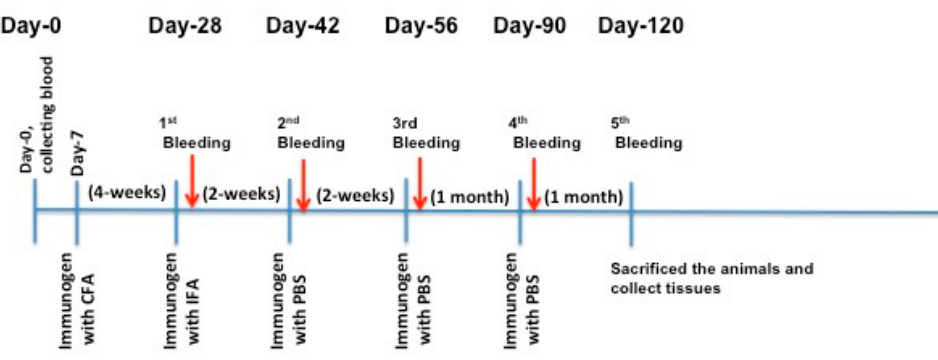
Figure 4. Immunization Strategy . Each mouse ( n = 5/group) was injected subcutaneously with 100 μ L of the immunogen (25 μ g/mouse) or PBS in complete Freund’s adjuvant (CFA) as the first injection. Four weeks later, the authors did the first boosting in incomplete Freund’s adjuvant (IFA), followed by injection once a month with X-isomer in PBS for three months. One week after each boost injection, mouse blood was collected for analysis of antibody production titer and cholesterol and triglyceride levels. The authors sacrificed the animals and collected tissues for RNA and protein analyses at the end of the study (day-120).